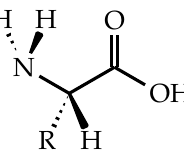
Figure 1. L -amino acid with its characteristic amino (-NH 2 ) and carboxyl (-COOH) functional groups and the side chain (-R).